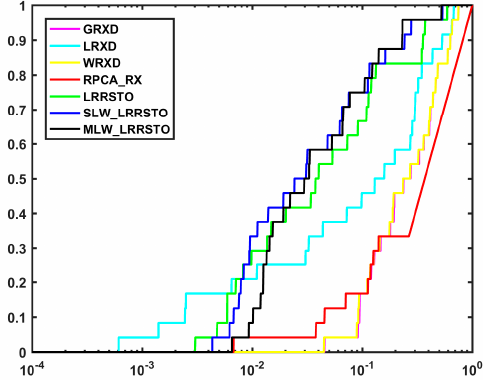
Figure 11. ROC evaluation of the different methods for the Viareggio dataset. Table 6. AUC values for the different detectors with the Viareggio dataset.